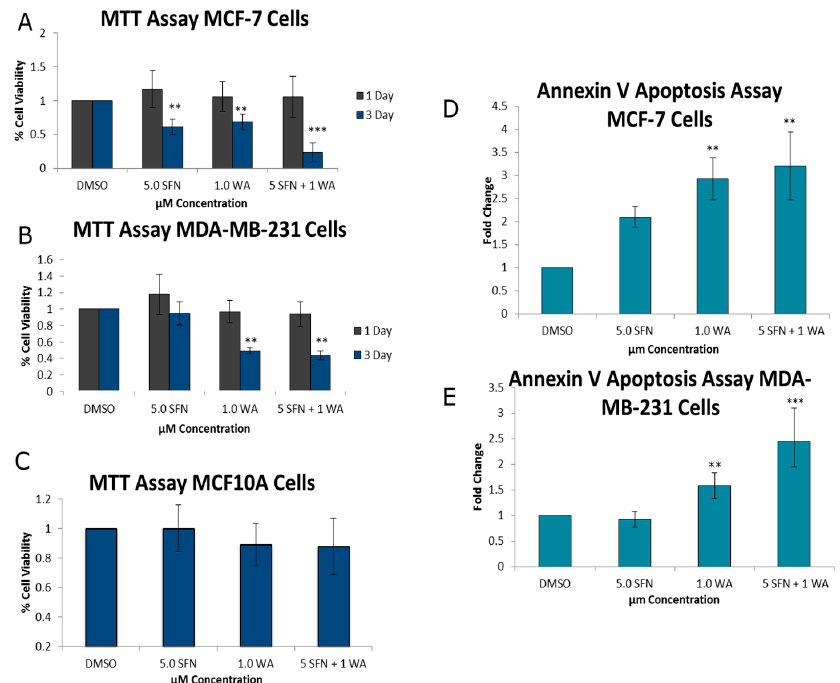
Figure 1. Combinatorial withaferin A (WA) and sulforaphane (SFN) decrease cellular viability and promotes apoptosis in breast cancer cells. ( A ) Assays with 3-(4,5-dimethylthiazol-2-yl)-diphenyl tetrazolium bromide (MTT) of MCF-7 breast cancer cells were performed using either 5.0 µM SFN, 1.0 µM WA, or both compounds at the indicated concentrations for a period of either 1 or 3 days; ( B ) MTT assays were performed on MDA-MB-231 cells for 1 or 3 days at the indicated concentrations; ( C ) MTT assay was performed on MCF10A cells for 3 days using the same concentrations mentioned previously; ( D ) Annexin V Apoptosis assay employing FACS analysis was completed on MCF-7 cells using 5.0 µM SFN, 1.0 µM WA, or 5.0 µM SFN + 1.0 µM WA for 3 days; ( E ) Apoptosis assay was completed on MDA-MB-231 breast cancer cells using 3-day treatments at the indicated concentrations of SFN, WA or both compounds (** p < 0.01, *** p < 0.001). The results represent three separately cultured experimental replicates. Numbers on the X-axis indicate compound